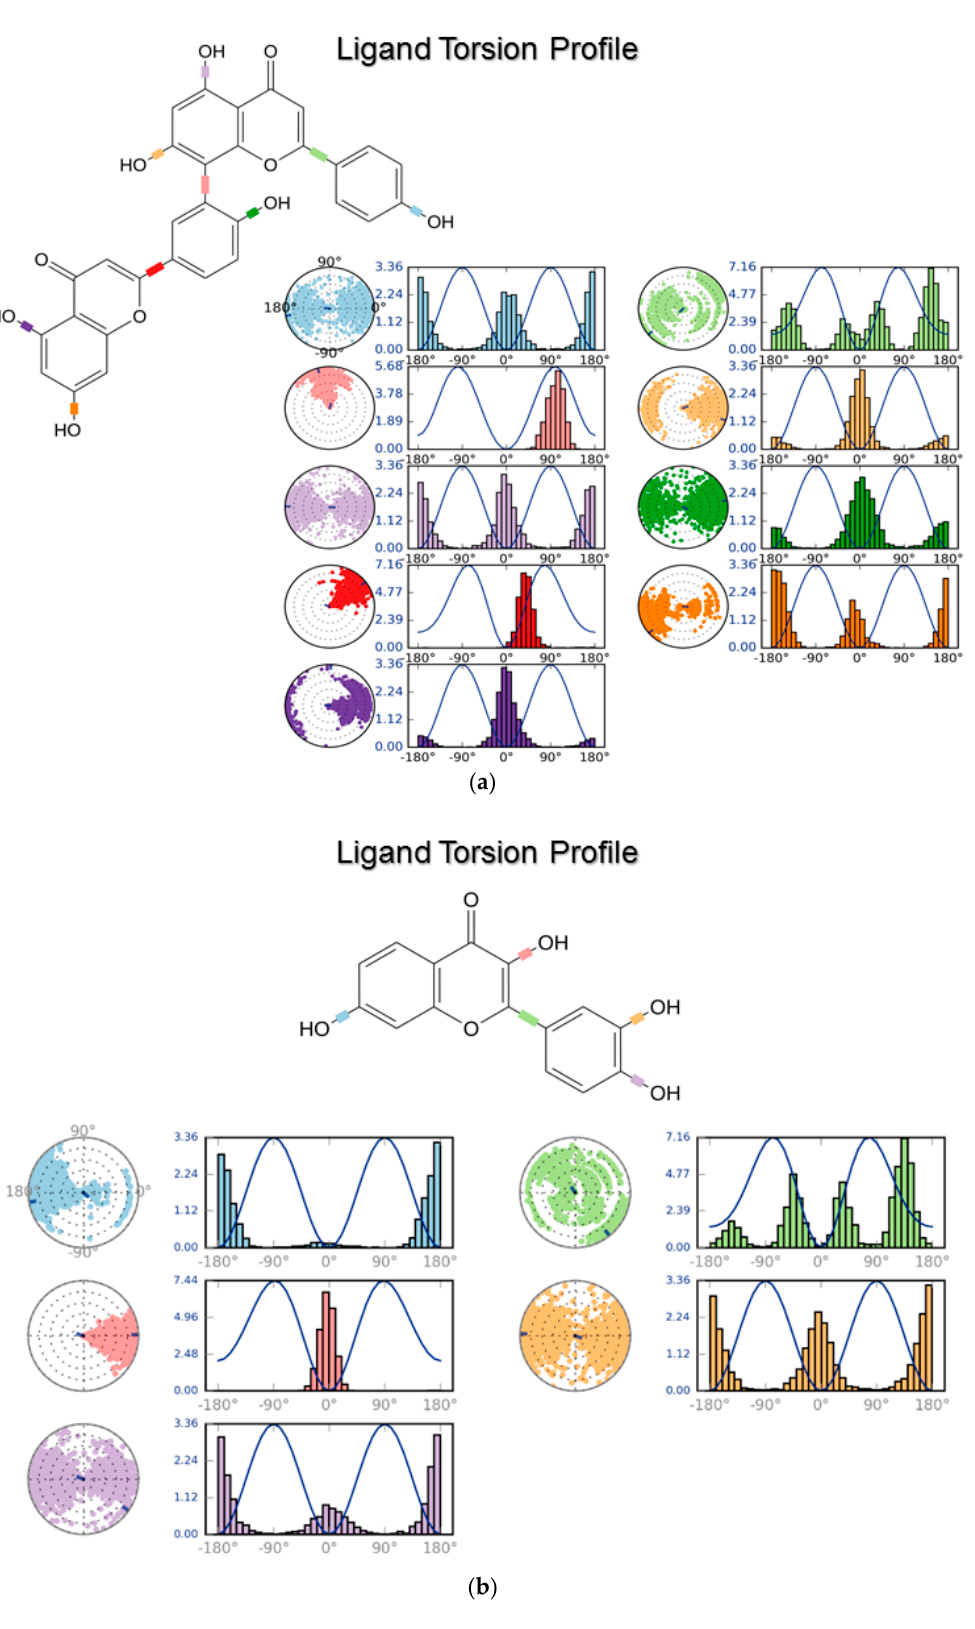
Figure 10. Torsional analysis of ligand conformations during the 100-ns simulations. ( a ) Amentoflavone; ( b ) Fisetin. The colors represent the different rotatable bonds of the ligands. Values on the Y-axis are in kcal/mol.